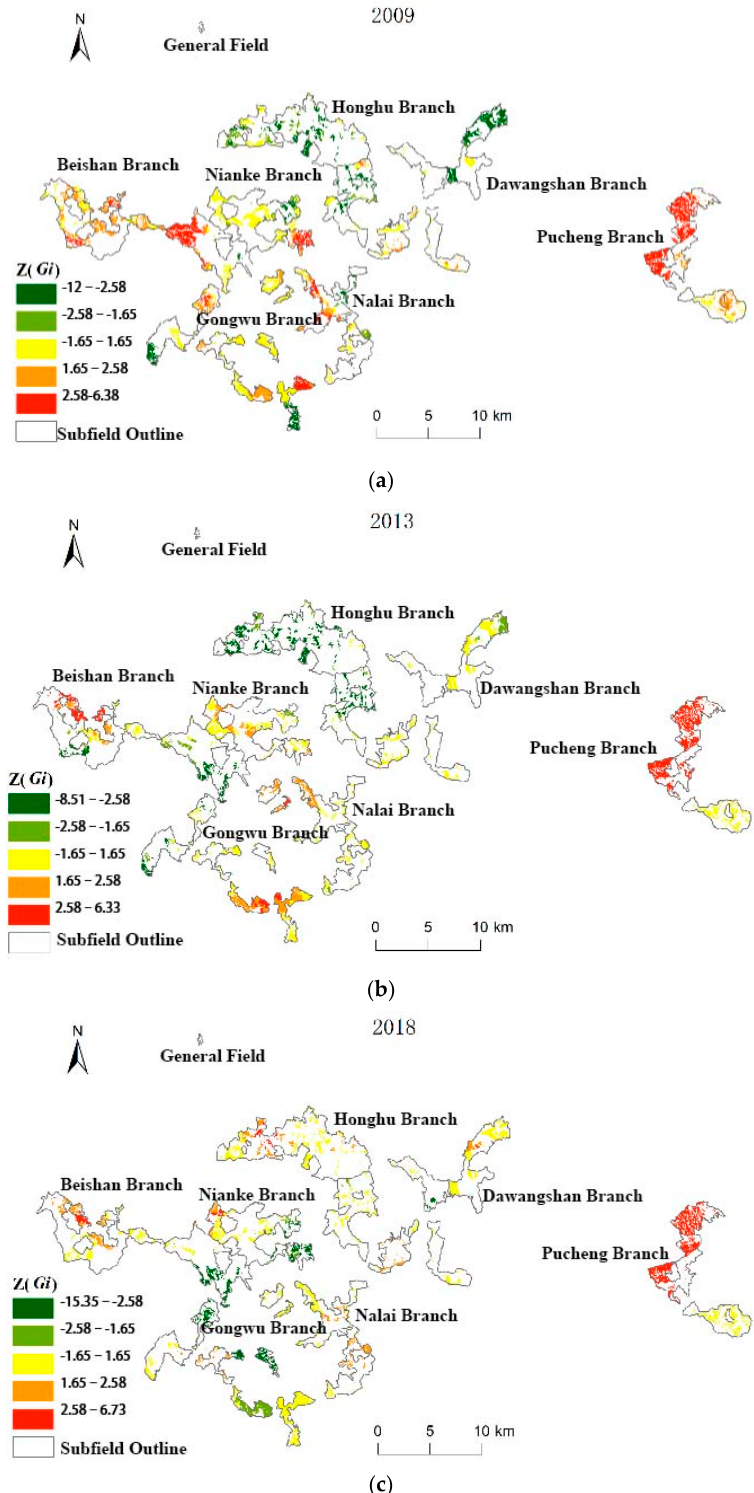
Figure 8. Distribution of cold–hot spots of carbon sequestration and oxygen release in PM Plantations in Paiyangshan Forest Farm from 2009 to 2018. Z(Gi*) is the aggregation index degree parameter. Red indicates a hot spot region, orange indicates a sub-hot spot region, yellow indicates an insignificant region, dark green indicates a cold spot region, and light green indicates a sub-cold spot region. The distribution of cold–hot spots of carbon sequestration and oxygen release is shown for the years 2009 ( a ), 2013 ( b ), and 2018 ( c ) in the following